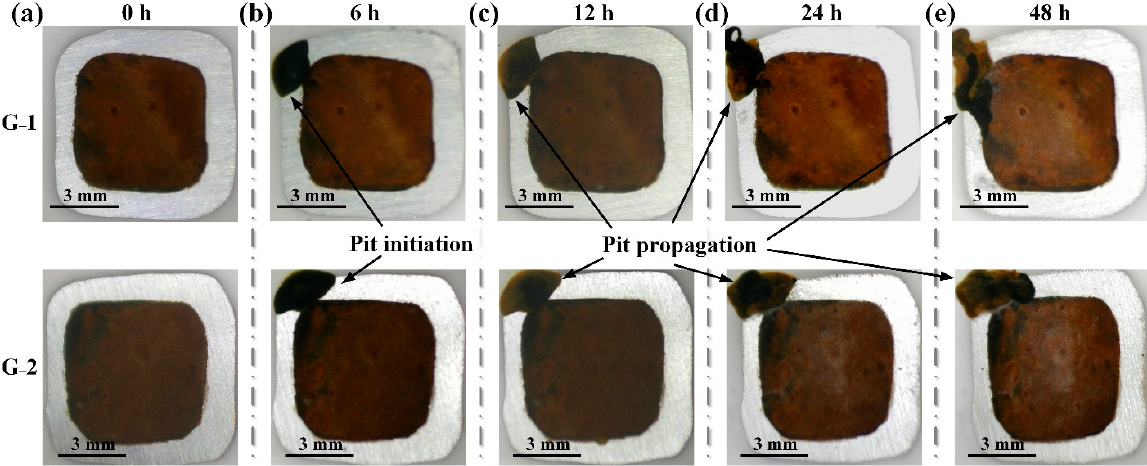
Figure 4. The surface morphology of two pre-rusted coupons after the introduction of chloride ions into the carbonated SCPS for ( a ) t = 0 h, ( b ) t = 6 h, ( c ) t = 12 h, ( d ) t = 24 h, ( e ) t = 48 h.